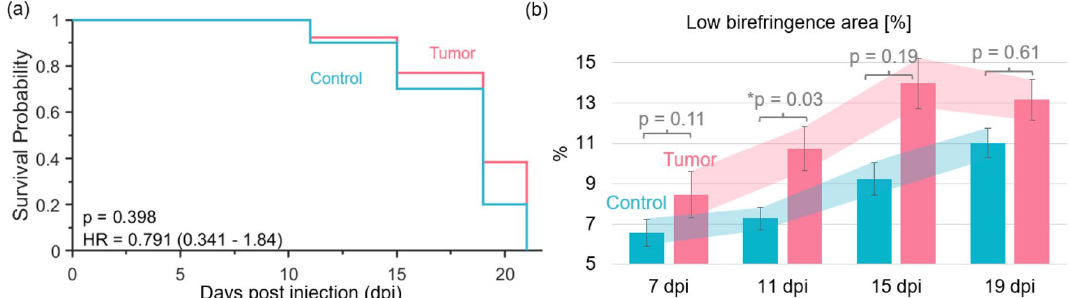
Figure 5. The survival and birefringence-based abnormality analysis. ( a ) Kaplan–Meier plot for the control and tumor zebrafish (HR—hazard ratio with 95% confidence intervals and the p-value of the log rank test are indicated). ( b ) Percentage of abnormal now birefringence values in the muscle region over the days post injection (dpi) with standard deviations indicated by vertical bars.